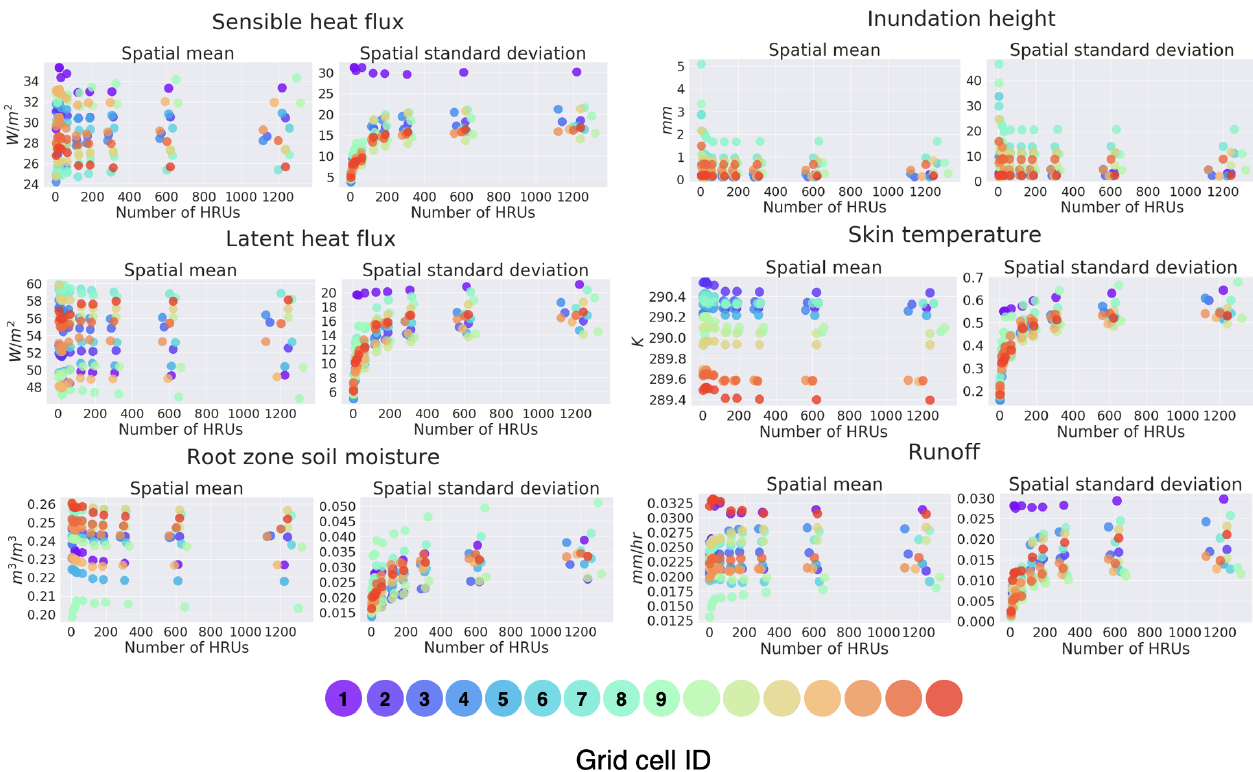
Figure 10. Convergence of annual mean of the spatial mean and spatial standard deviation of runoff, land surface temperature, inundation height, root zone soil moisture, latent heat flux, and sensible heat flux for the 9 different HRU configurations. Each color denotes a different macroscale polygon in the 1.0 ◦ SGP